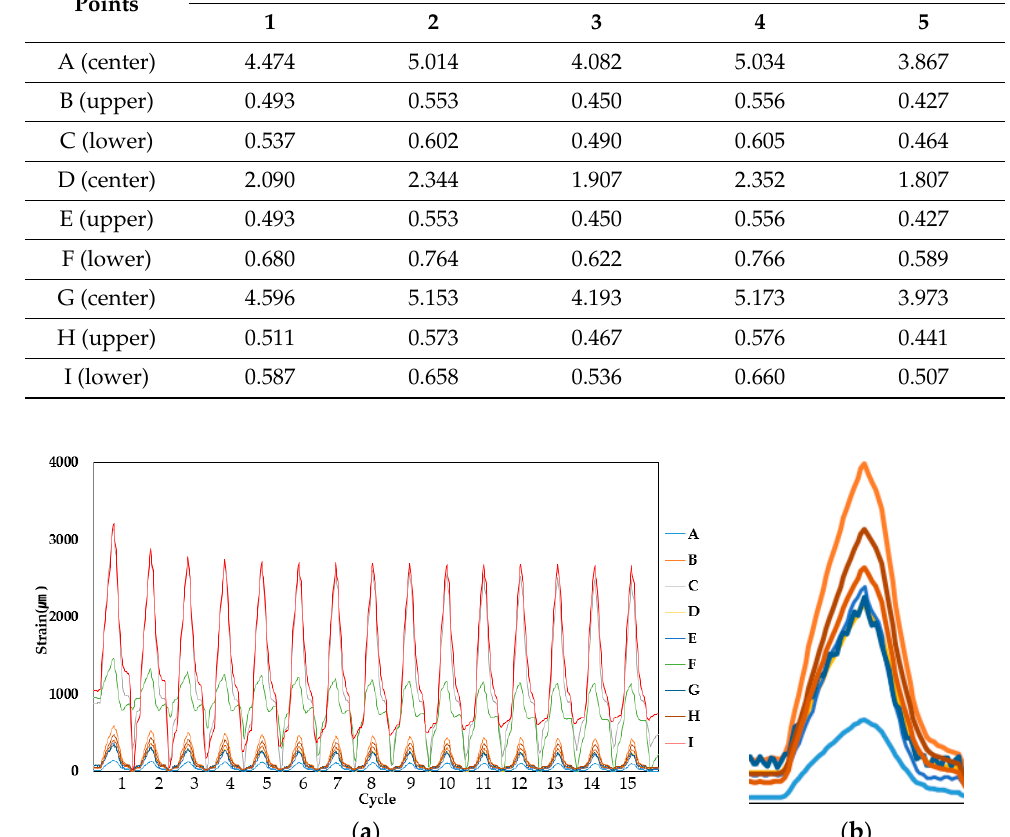
Figure 7. PUC (Specimen 1, 1.5 mm specimen sample) strain measurement result: ( a ) overall result and ( b ) single peak results of upper and lower section strain, magnified.